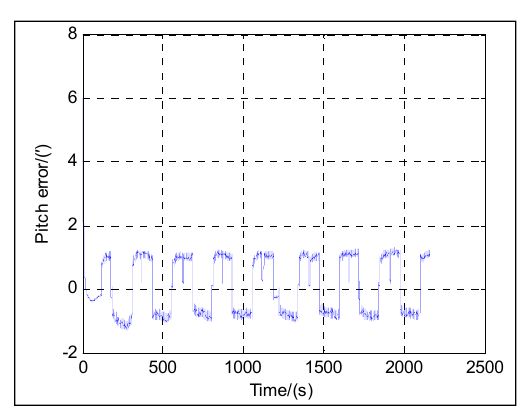
Figure 16. Pitch error.